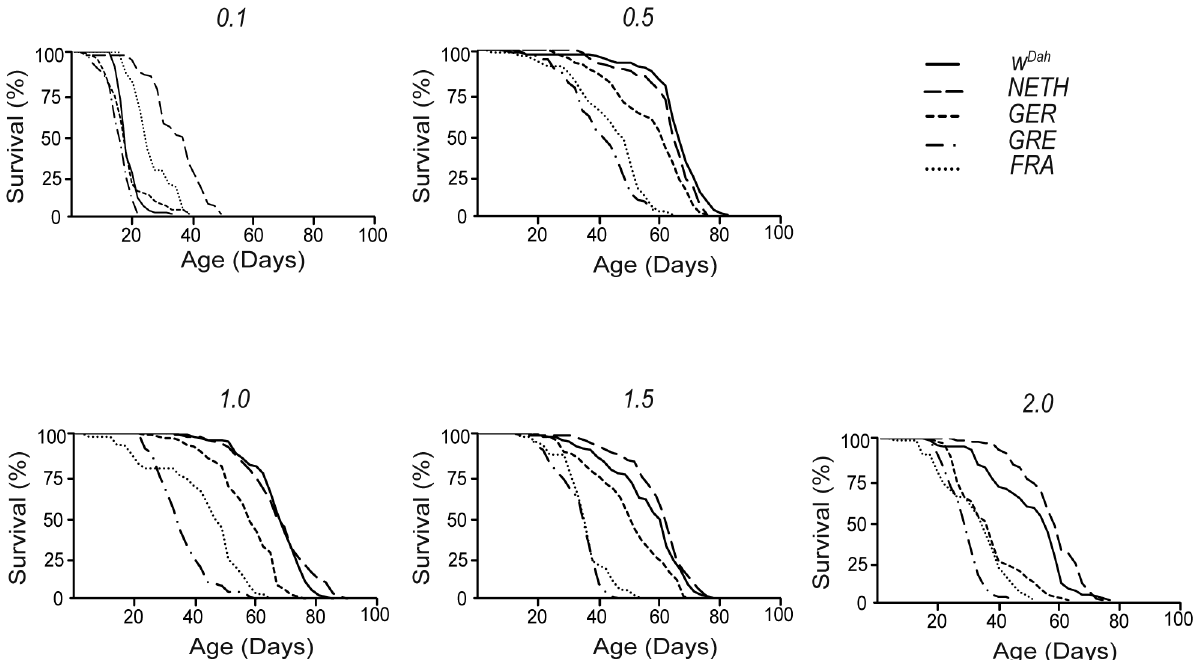
Figure 2. Survival curves for all strains on all foods. W Dah and NETH strains lived longer than any other strain under non-starvation conditions ( p , 10 2 4 , log rank test). At 0.1 and 2 yeast concentrations NETH strain lived longer than W Dah ( p , 10 2 4 , log rank test), however at other yeast concentrations their lifespans did not differ significantly ( p . 0.05, log rank test).